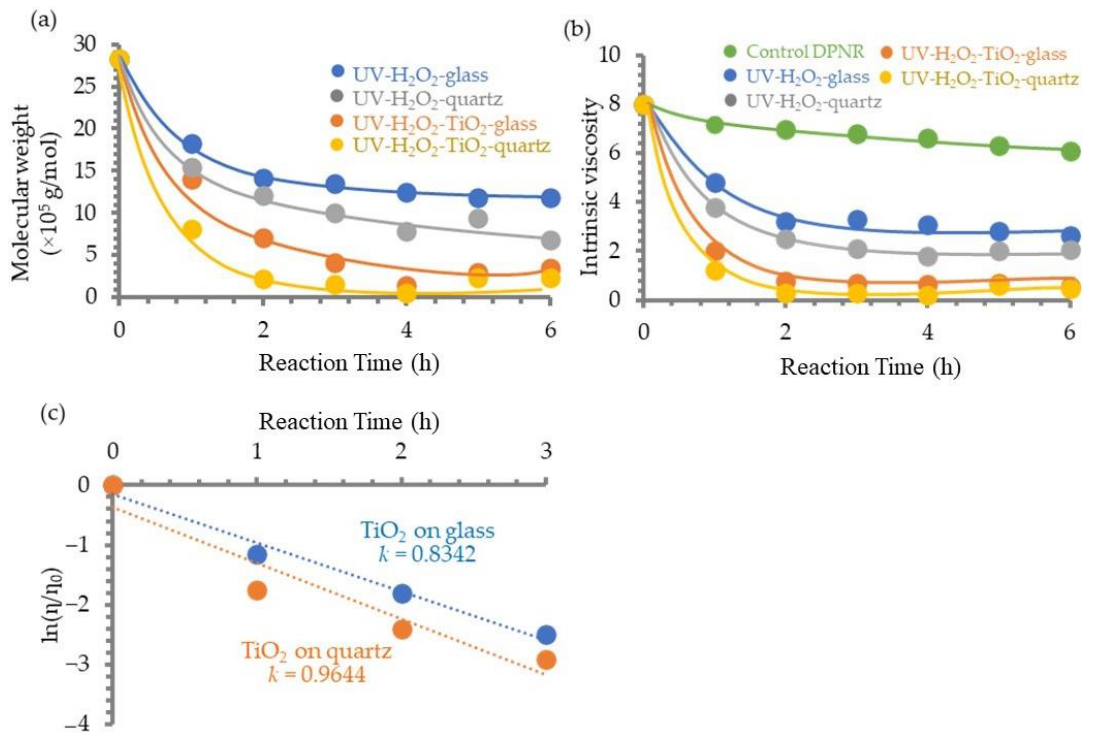
Figure 4. The effect of TiO 2 film and substrate types on ( a ) the MW and ( b ) the intrinsic viscosity of DPNR and UV irradiation time, and ( c ) the relationship of ln relative viscosity of DPNR and UV irradiation time.